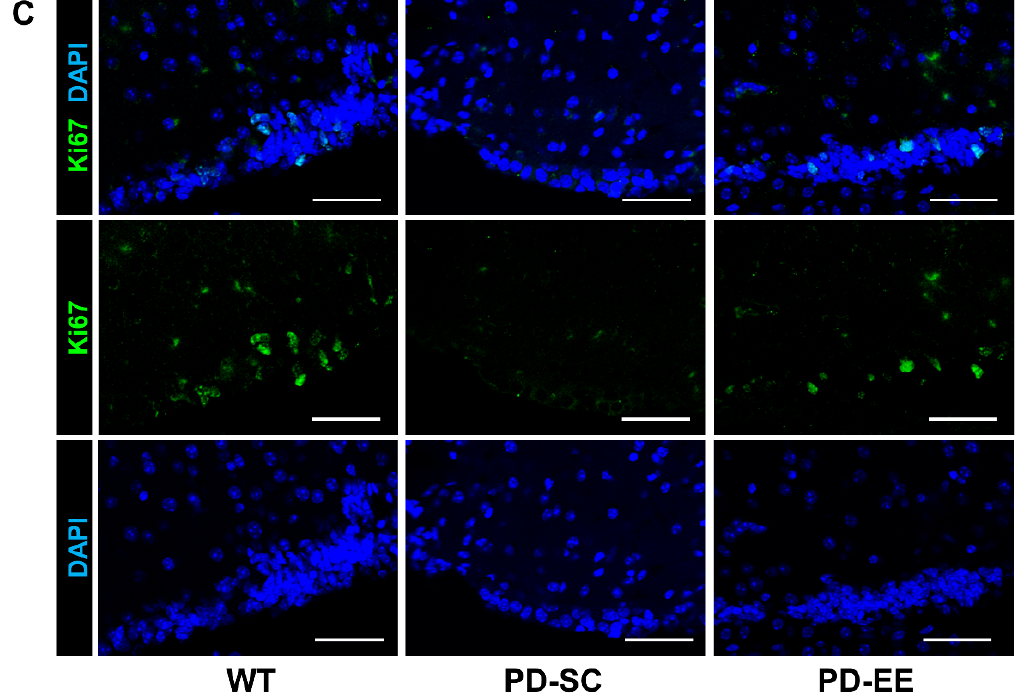
Figure 5. EE preserved cell proliferation in the SVZ of PD mice. ( A ) The density of Ki-67 was evaluated in the SVZ. ( B ) The density of Ki-67 was significantly lower in the PD-SC mice compared with both the WT and PD-EE mice. No significant differences were observed between the WT and PD-EE mice ( n = 3 each). ( C ) Representative confocal microscopic images of Ki-67 + cells in the SVZ of sagittal sections. Astrocytes are green in color. Blue color indicates DAPI + nuclei. The scale bar represents 50 μ m. ** p < 0.01; *** p < 0.001; one-way ANOVA followed by post-hoc comparison.